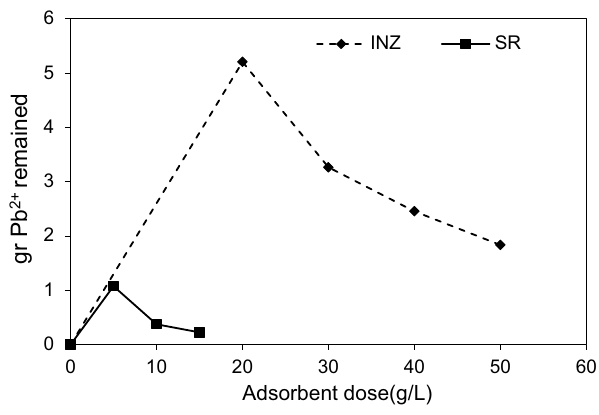
Fig. 6 Influence of pH changes on Pb 2+ removal efficiency (initial concentration = 50 mg/L, contact time = 120 min, adsorbent dose: INZ = 30 g/L, SR = 10